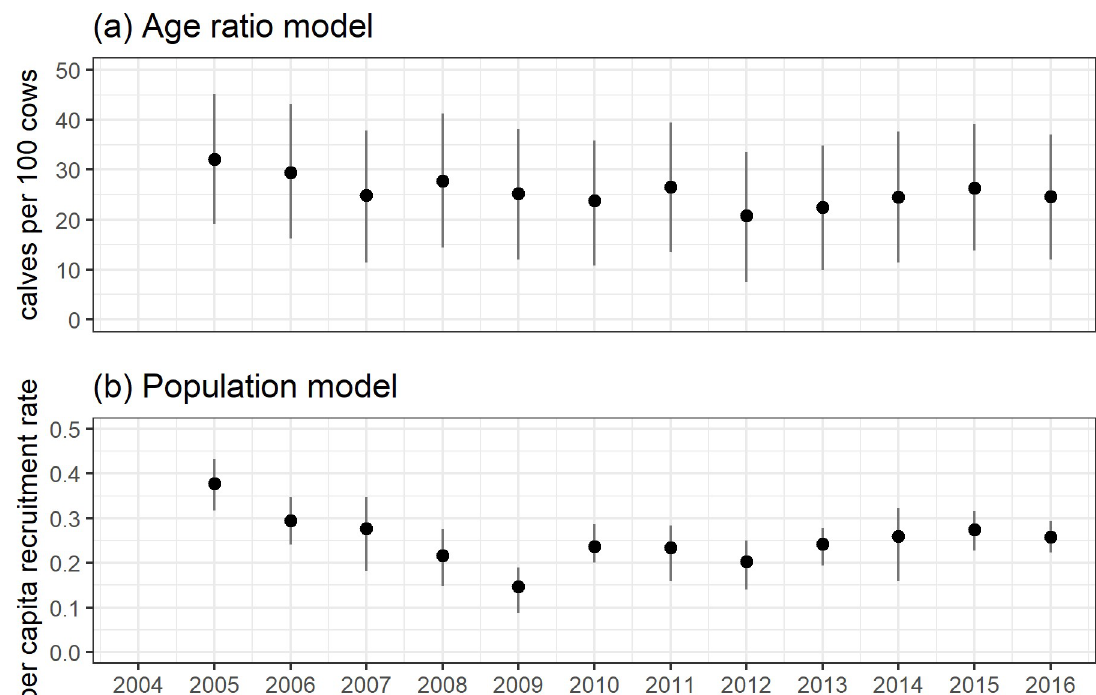
Fig 6. Estimated yearly random effects for (a) age ratios, and (b) per capita recruitment rates. These values were calculated by holding all other covariates to their mean (zero) and represent predicted values for average conditions. The black dot denotes the median of the approximate posterior distribution, the heavy black line the 50% highest posterior density interval (HPD) and the light black line the 90% HPD interval.